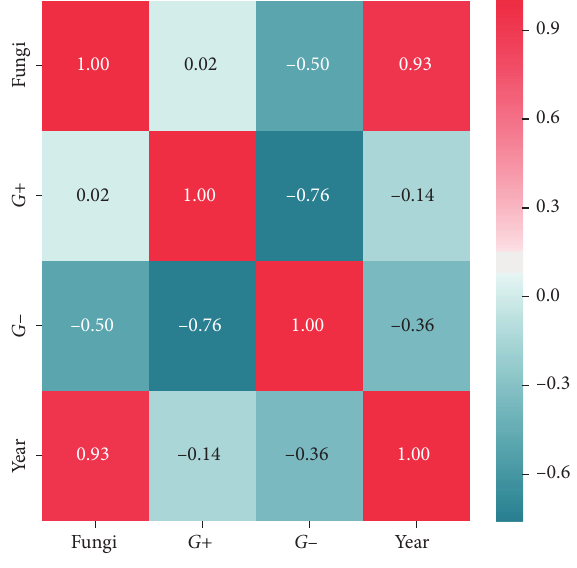
Figure 3: Spearman’s correlation